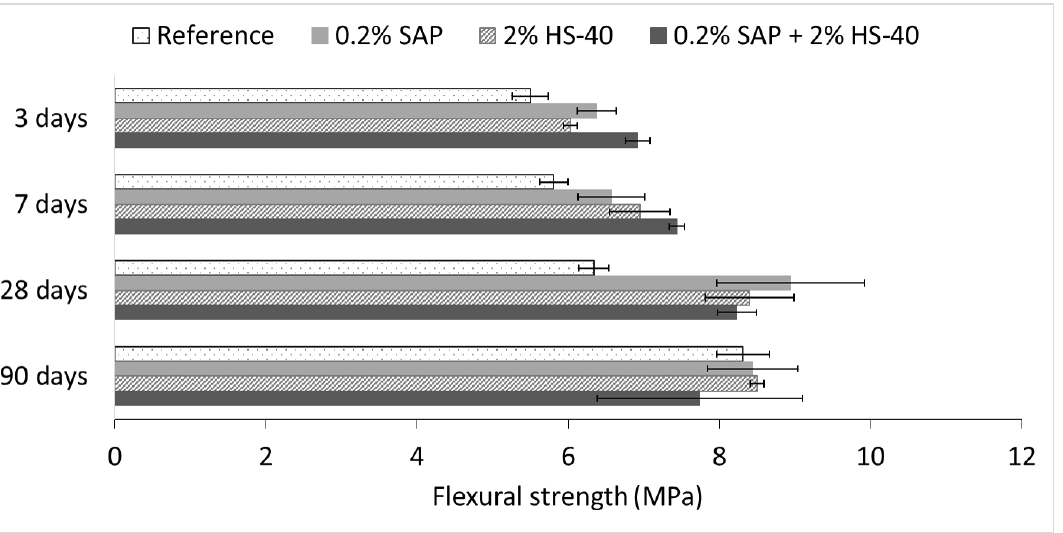
Figure 8. Flexural strength of all series measured at 3, 7, 28 and 90 days. Materials 2020 , 13 , 380